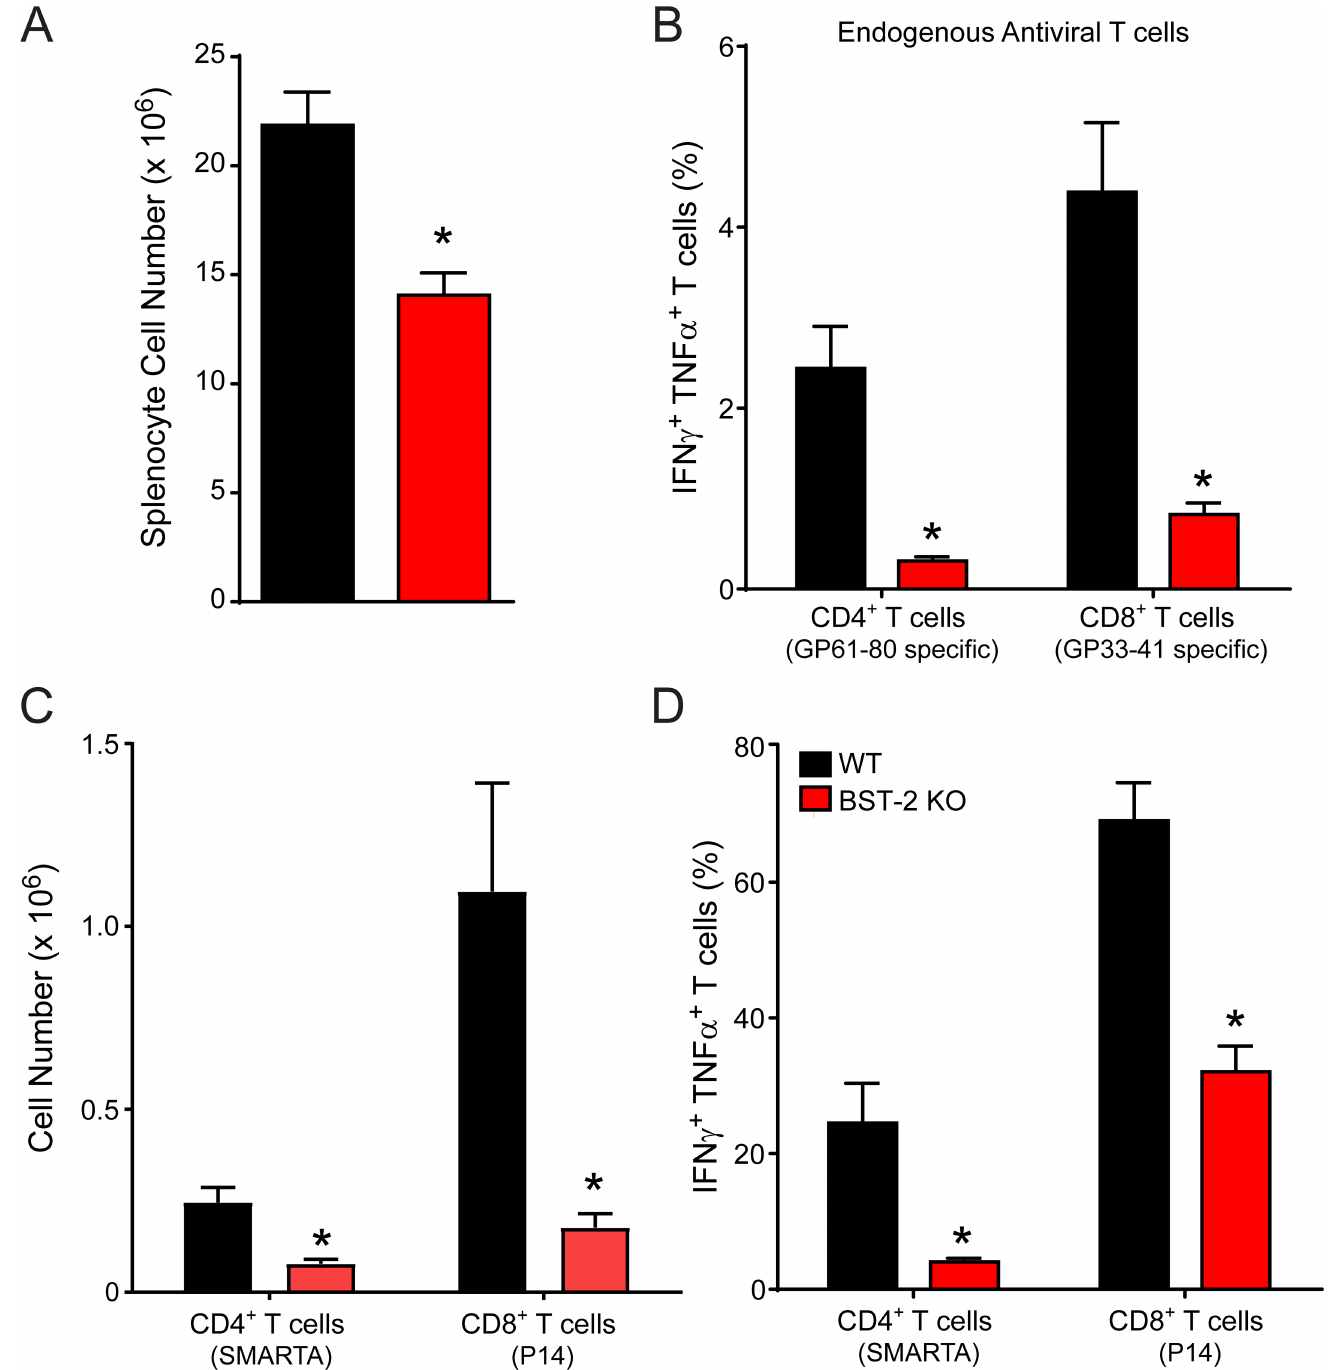
Fig 5. Antiviral T cell function and expansion is reduced in BST-2 deficient mice. A-D. Naïve WT and BST-2 KO mice that received 2,000 Thy1.1+ P14 and 2,000 CD45.1+ SMARTA cells were infected with LCMV Cl-13. On day 8 post-infection, the absolute number of splenocytes (A), P14 cells (C), and SMARTA (C) cells was quantified. In addition, the percentage of endogenous (B) and transferred (D) IFN γ + TNF α + antiviral T cells was determined following a 5 hr in vitro stimulation with GP33-41 (CD8) or GP61-80 (CD4) peptide (n = 9 mice per group; 2 independent experiments). Data are represented as mean ± SD. Asterisks denote statistical significance ( (cid:3) P <